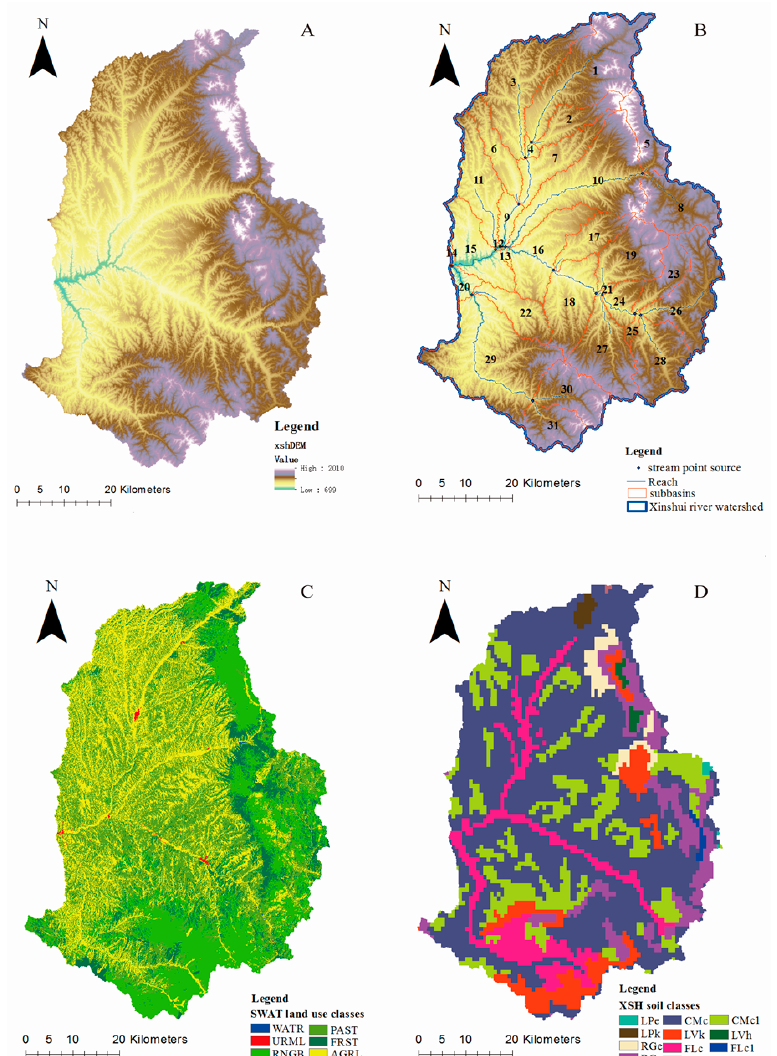
Figure 2. Digital elevation model (DEM) ( A ), sub-watershed delineation map ( B ), land-use map ( C ), and soil map ( D ) of Xinshui River Watershed used during data preparation.